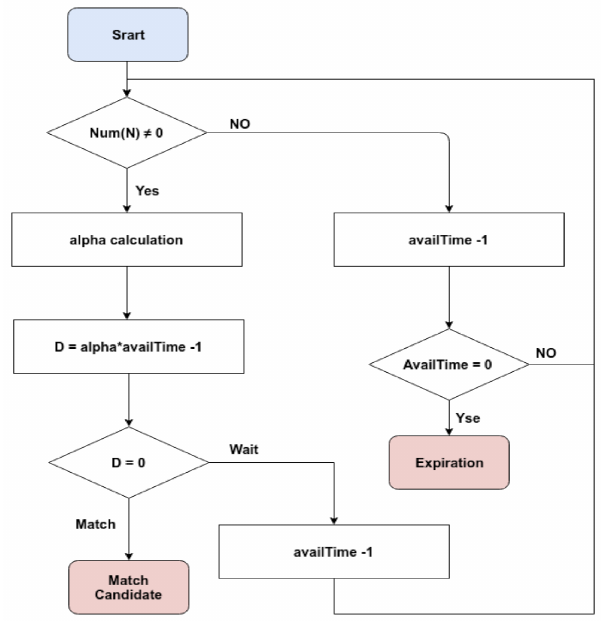
Figure 12. The detailed processing flow of the proposed DTS-based matching